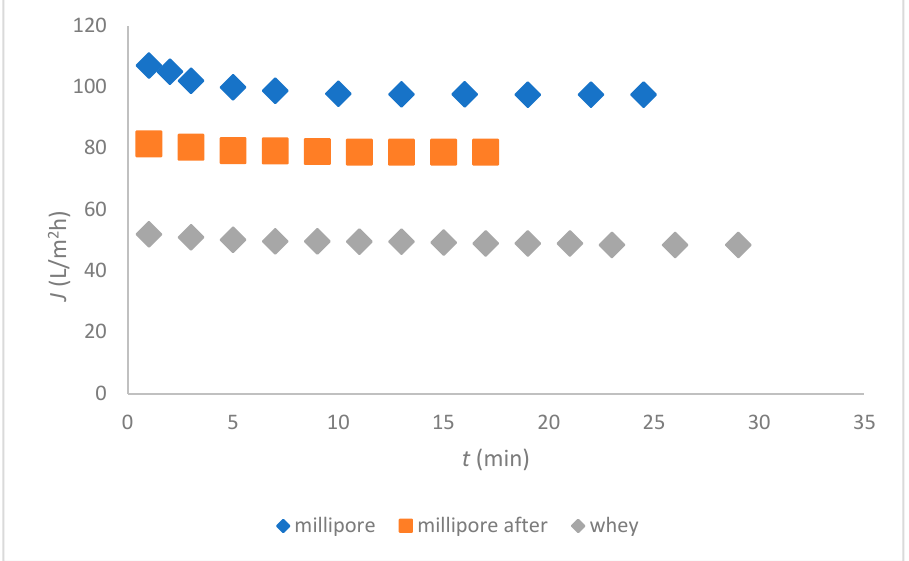
Figure 7. Flux dependent on time for the NF membrane.